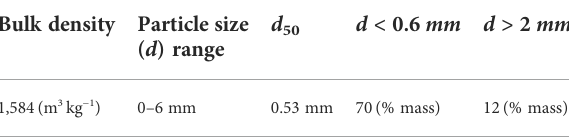
TABLE 1 Characteristics of the sand used in the